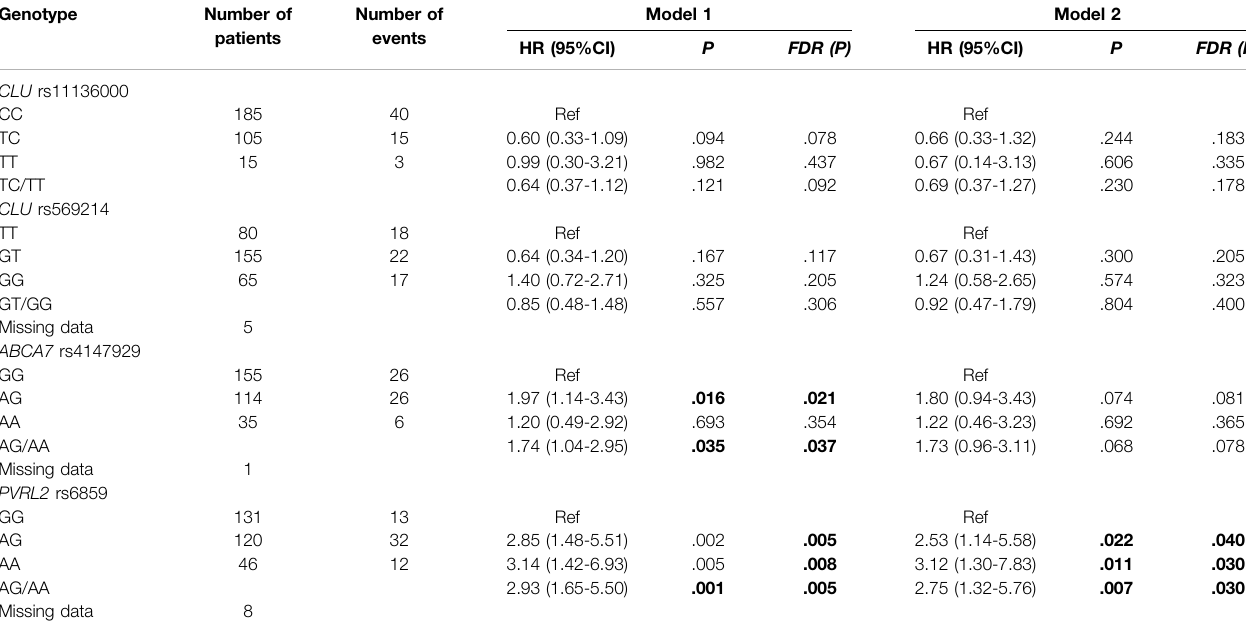
TABLE 2 | Characteristics of MCI participants. Characteristic